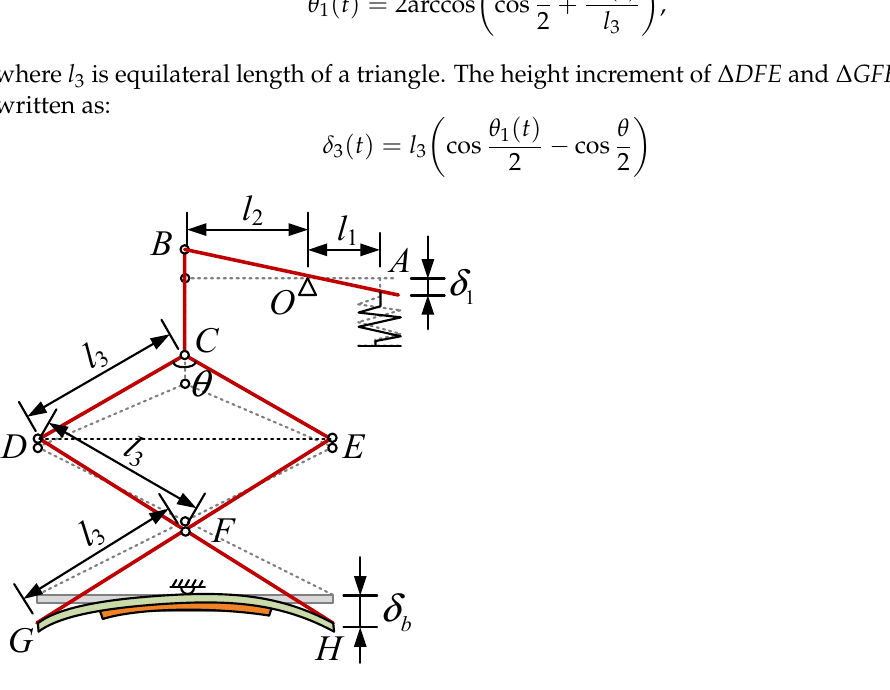
Figure 4. Displacement calculation diagram of each part under external excitation.